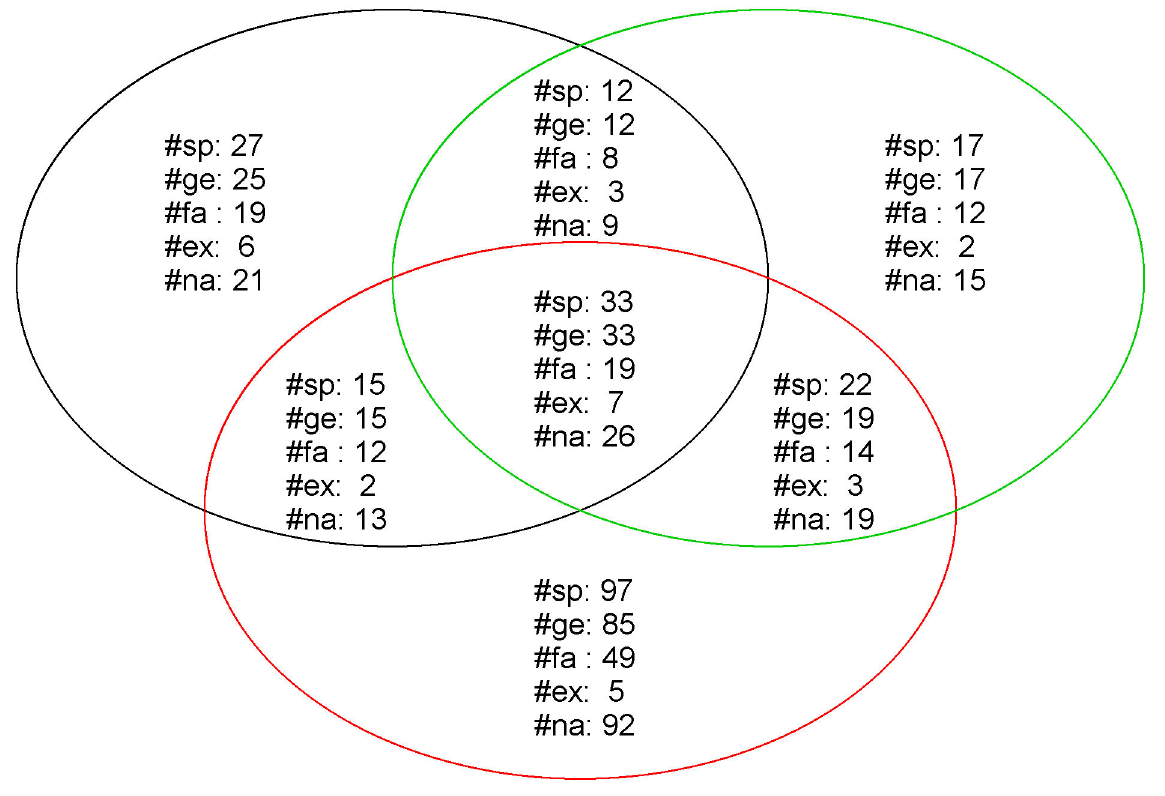
Figure 2. Venn diagram showing the species composition across the three types of forests. Black circle represents eucalyptus plantation, Green circle represents rubber plantation; and Red circle represents secondary forest. Abbreviations: #sp (number of species), #ge (number of genera), #fa (number of families), #ex (numer of exotic species), and #na (number of native